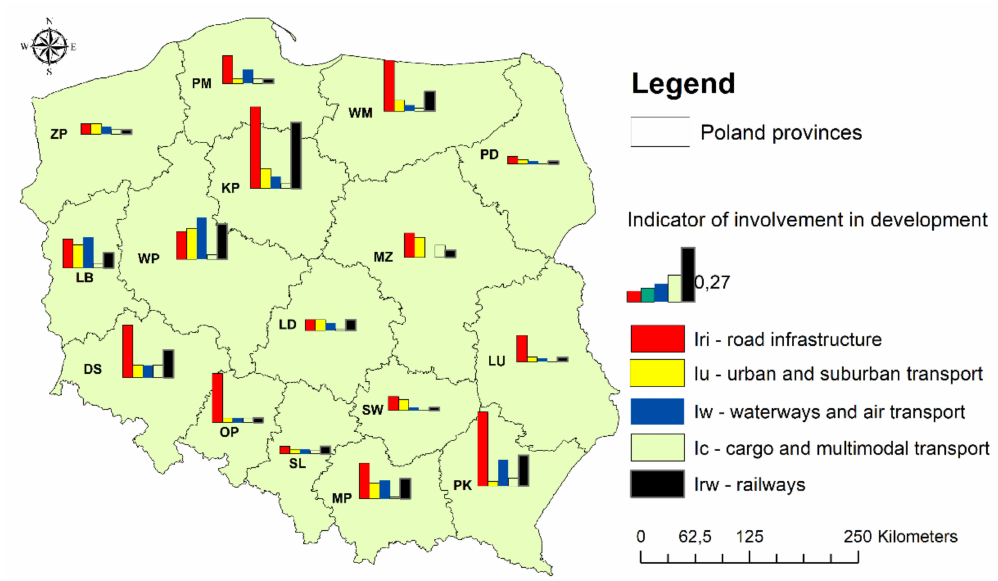
Figure 4. Involvement of the provinces in transport development—a comparison of the indicators of involvement. Source: the